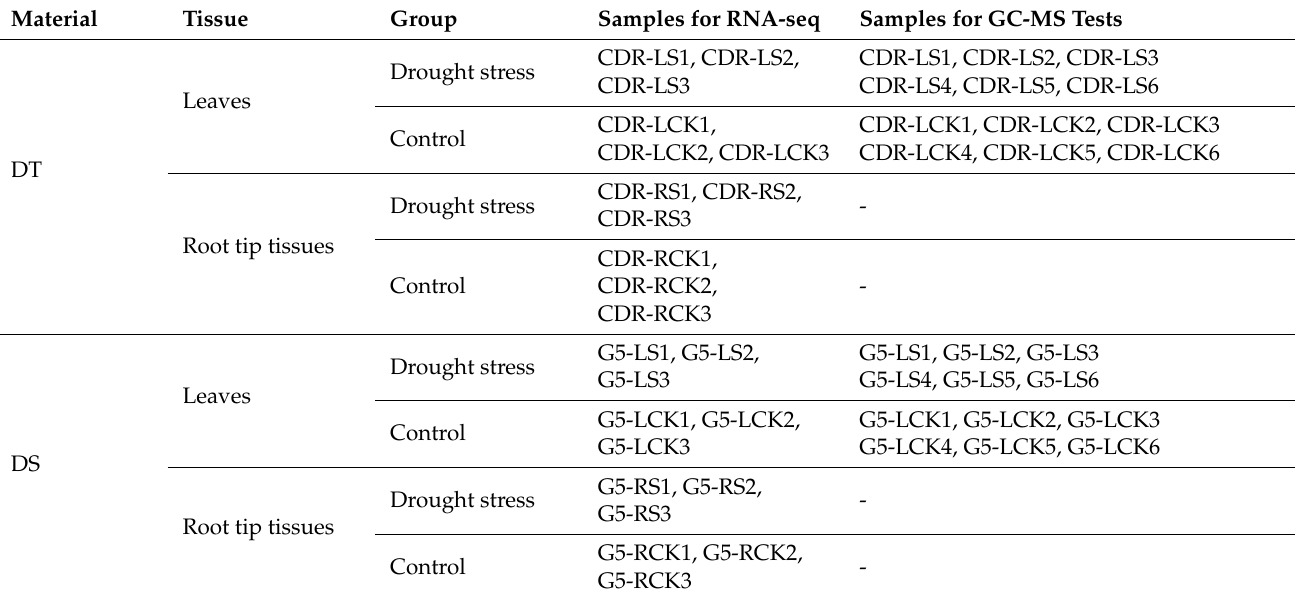
Table 1. Experimental sampling